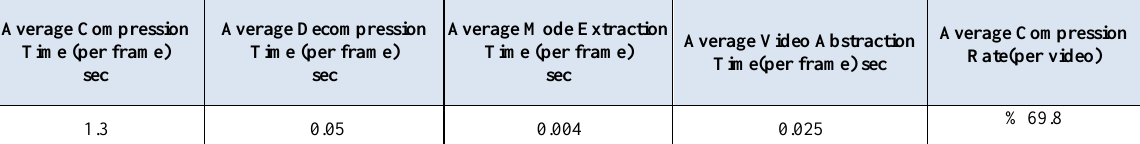
Table 1. Timing and memory specifications of the processes performed in the proposed method.